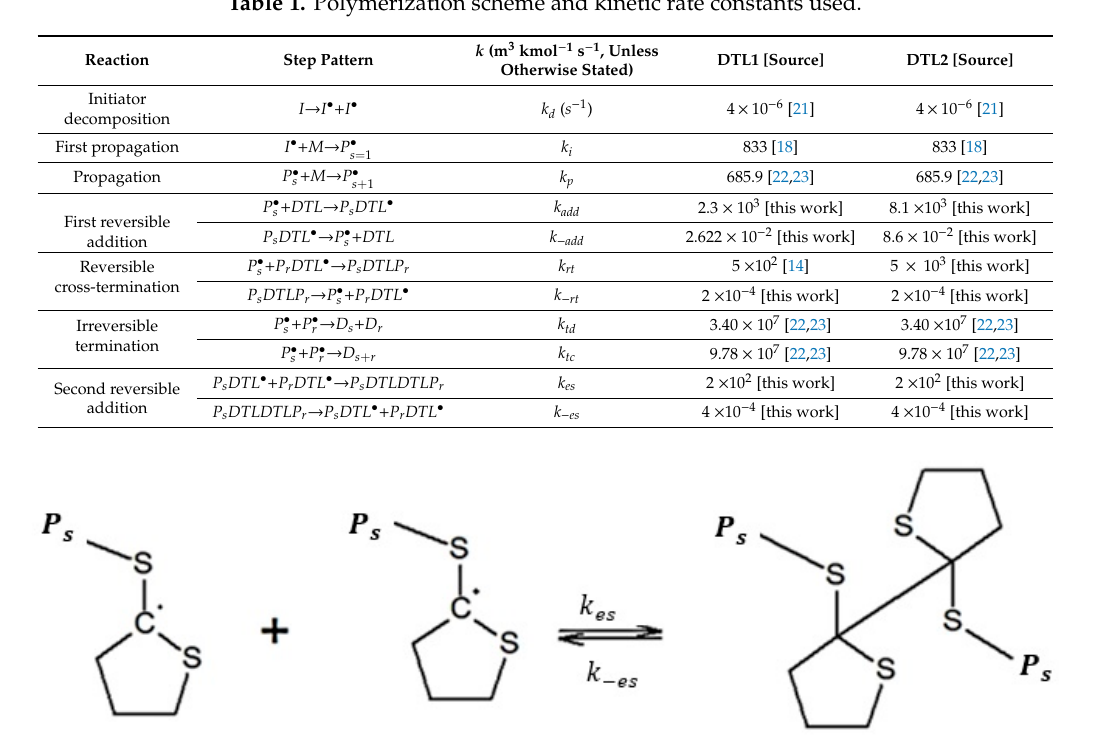
Table 1. Polymerization scheme and kinetic rate constants used.